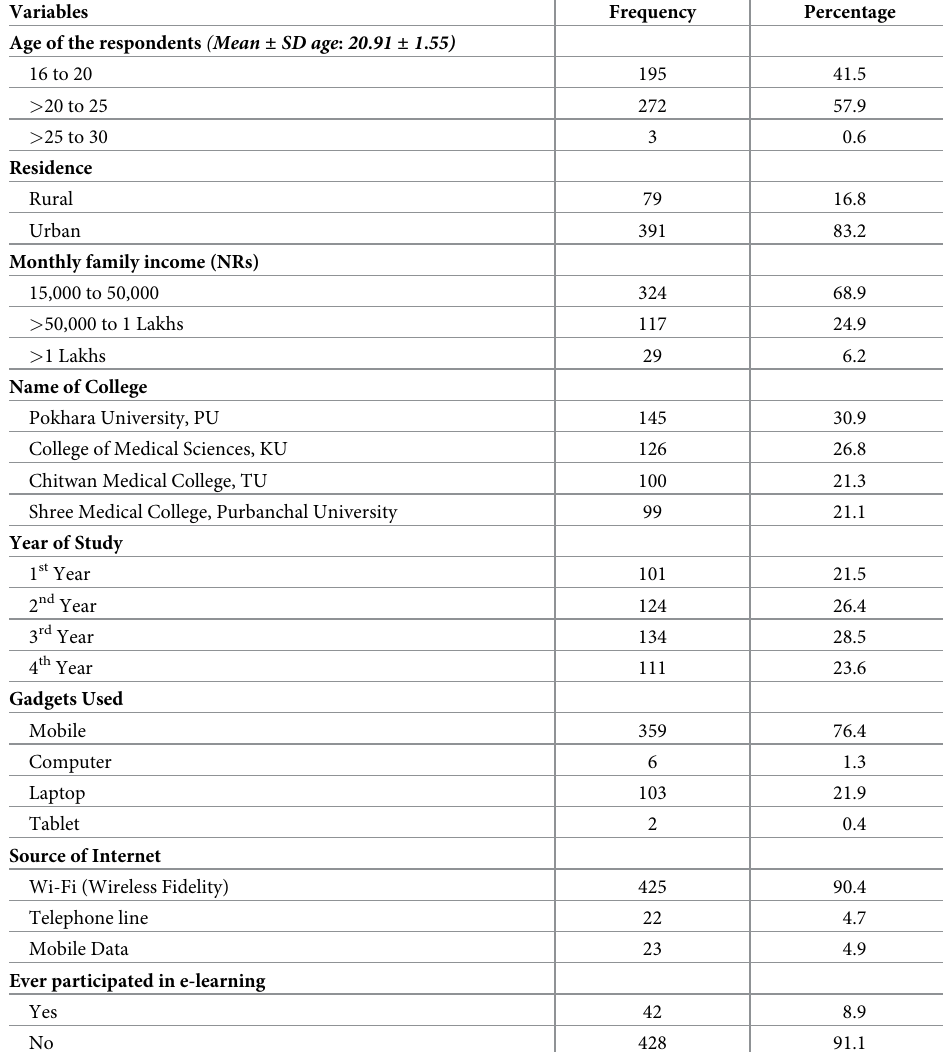
Table 1. Socio-demographic characteristics of the respondents (n = 470). Variables Frequency Age of the respondents ( Mean ± SD age : 20 . 91 ± 1 .